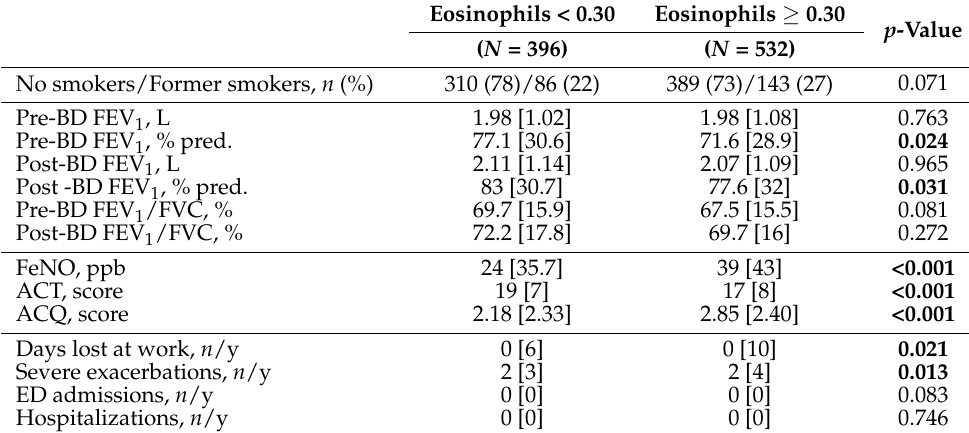
Table 3. Study population clustered by blood